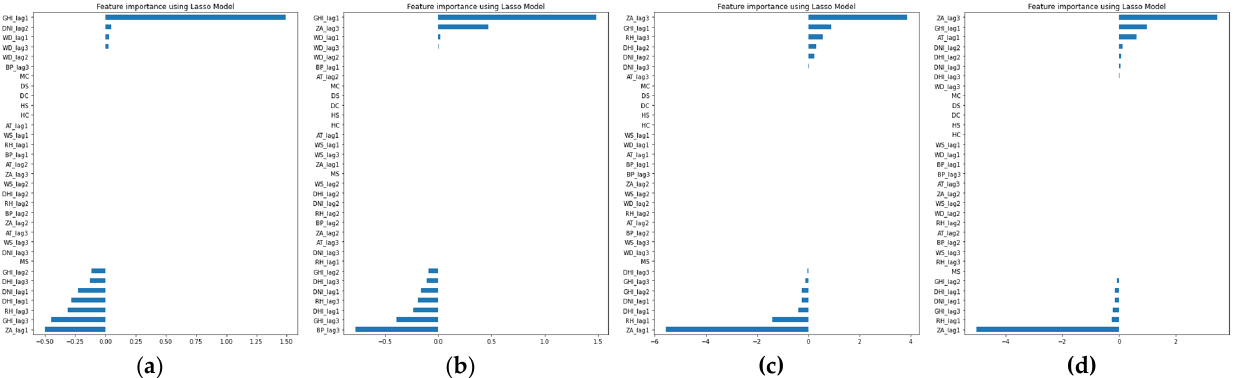
Figure 16. Selected features based on the LASSO method: ( a ) Al-Jouf; ( b ) Al-Khafji; ( c ) Caracas; ( d ) Toronto.